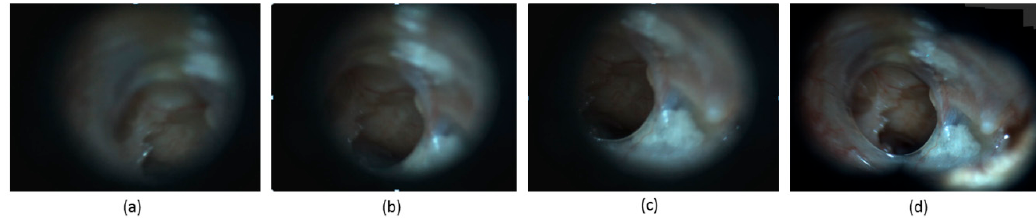
Figure 5. The image stitching result for three of the selected frames. The stitching process expands the original field-of-view of the input frames. ( a – c ) Input images, ( d ) stitching result.